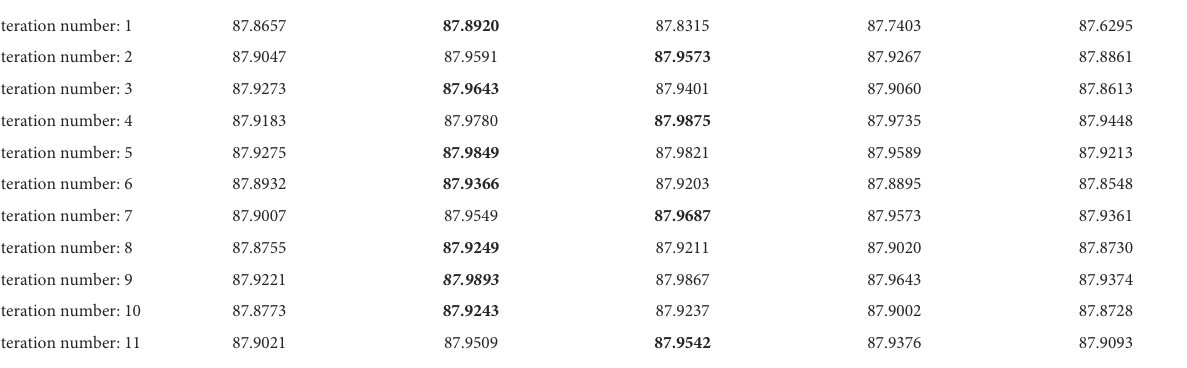
TABLE 4 The average dice scores (%) of original-scale network with different parameters on mouse brain test set.